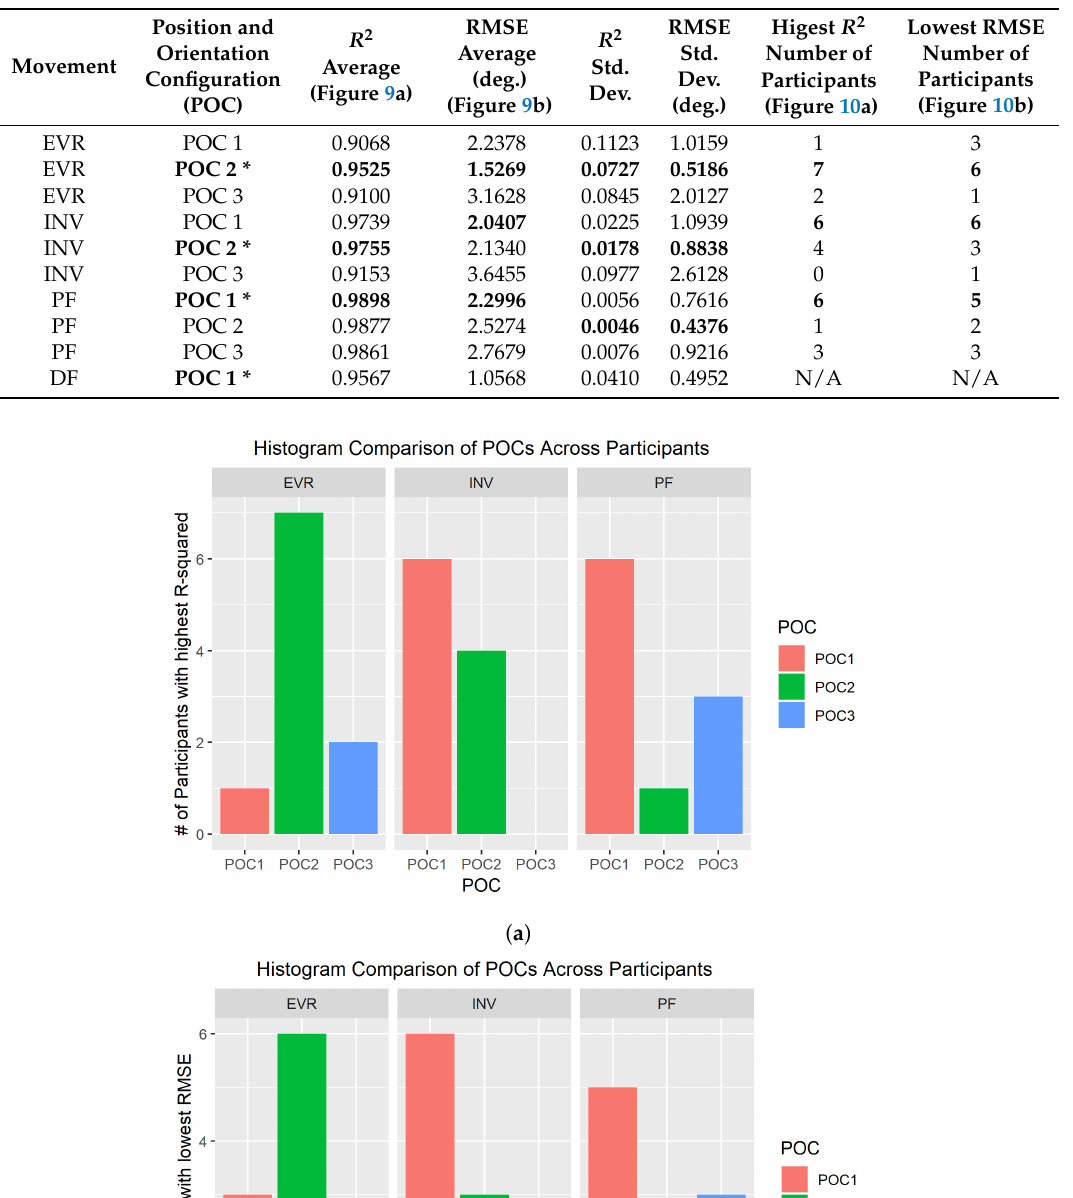
Table 1. Averages, standard deviations, and participant count of R 2 and RMSE values for all POCs; best POC in bold. * Denotes preferred POC location for each of the four foot–ankle movements. Deg., degrees; Std. Dev., standard deviation.